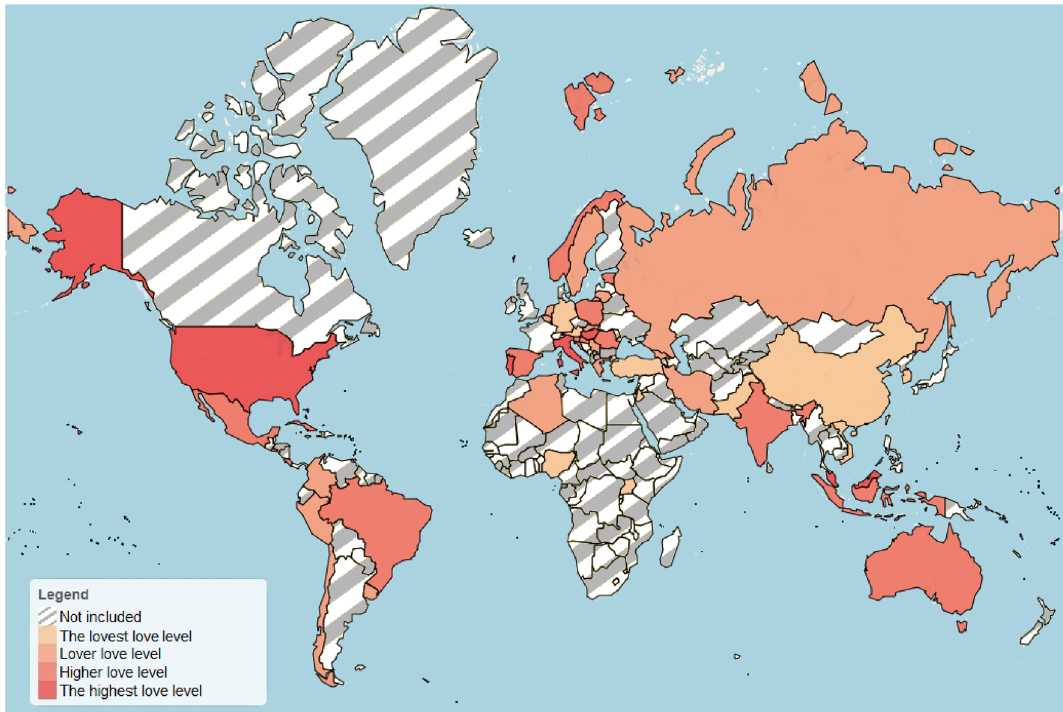
Figure 1. Levels of love (comprised of 45 items from the Triangular Love Scale) across the